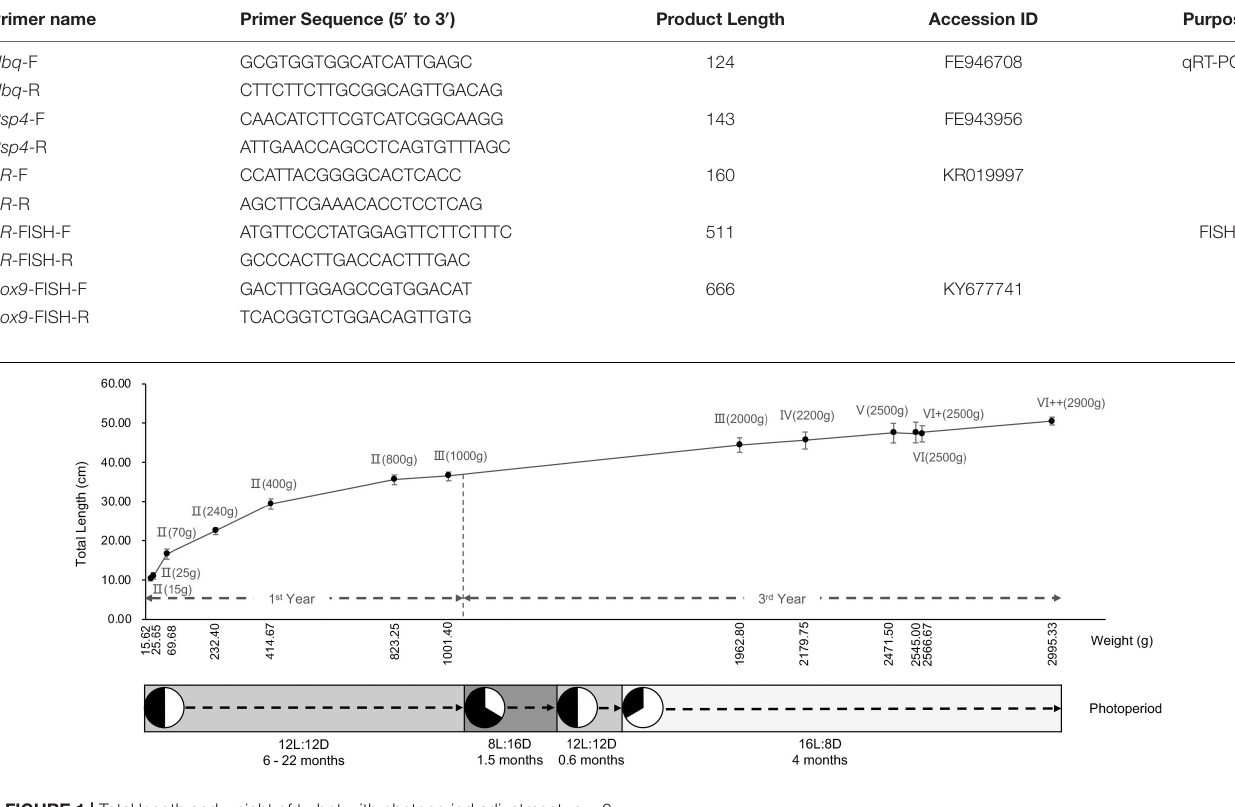
FIGURE 1 | Total length and weight of turbot with photoperiod adjustment. n = 6.